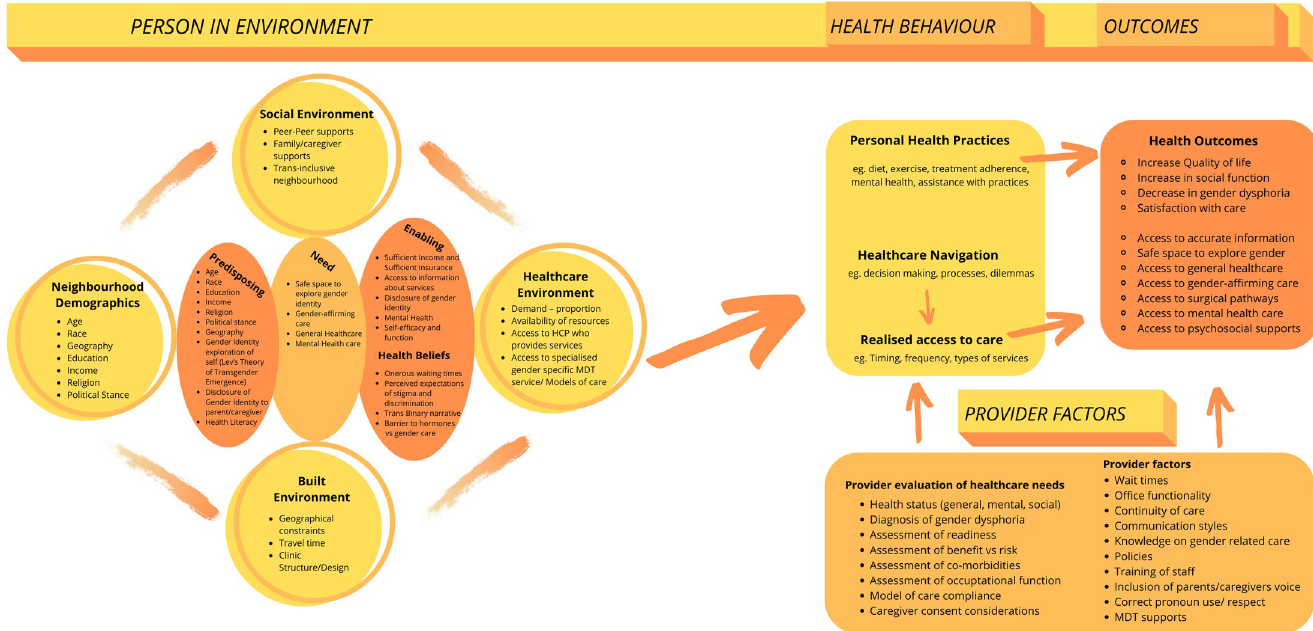
Fig 4. Adapted Ryvickers’ behavioural ecological model for healthcare navigation of transgender and non-binary youth.